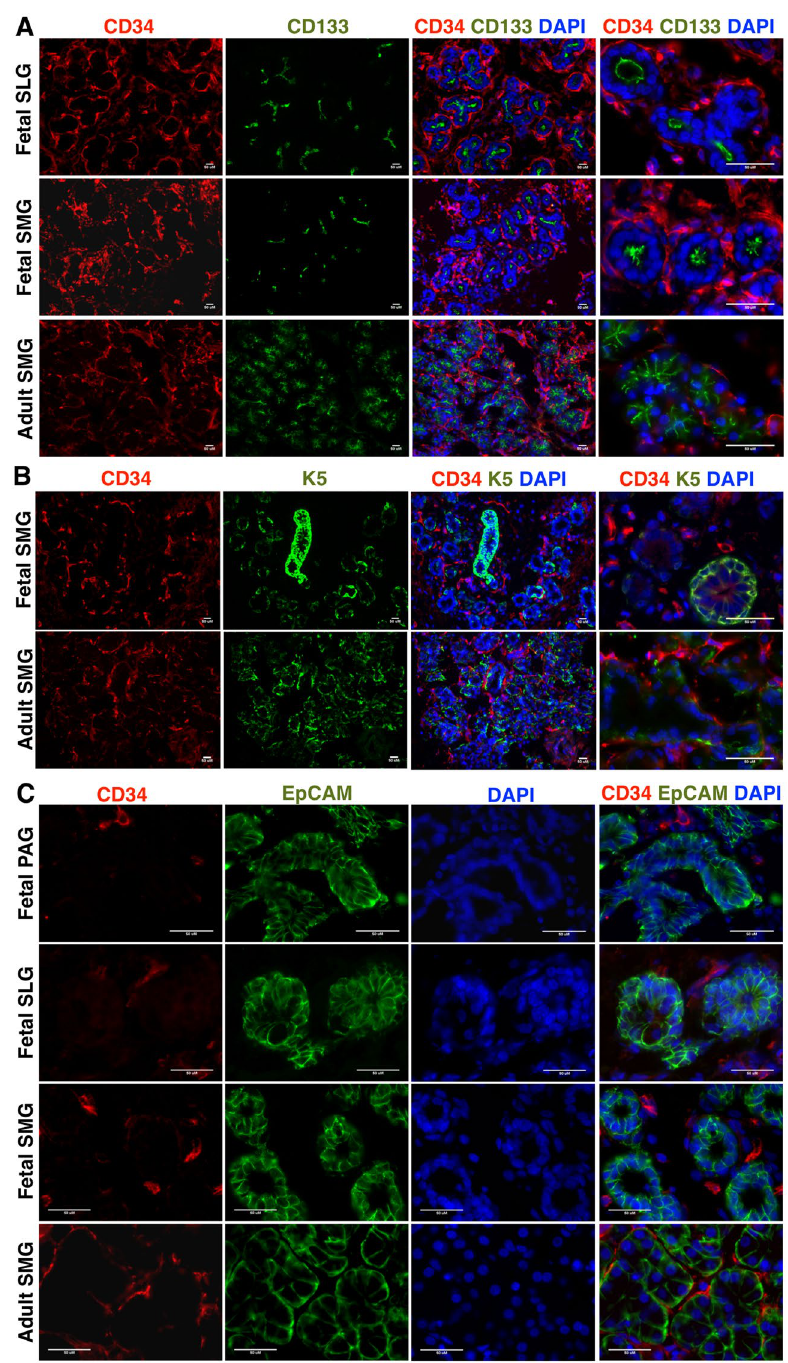
Figure 4. In situ localization of ( A ) CD34 (red) and CD133 (green) ( B ) CD34 (red) and K5 (green) ( C ) CD34 (red) and EpCAM (green) in fetal SLGs, SMGs, and adult SMGs. All scale bars represent 50 µ